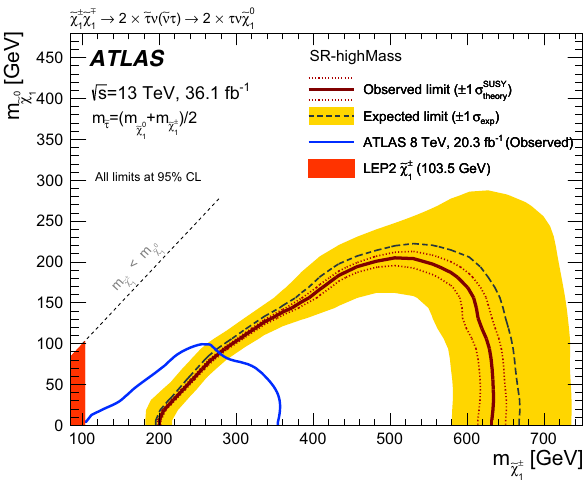
˜ χ − ˜ χ 0 ˜ χ + ˜ χ ± 1 1 and 1 2 (right).